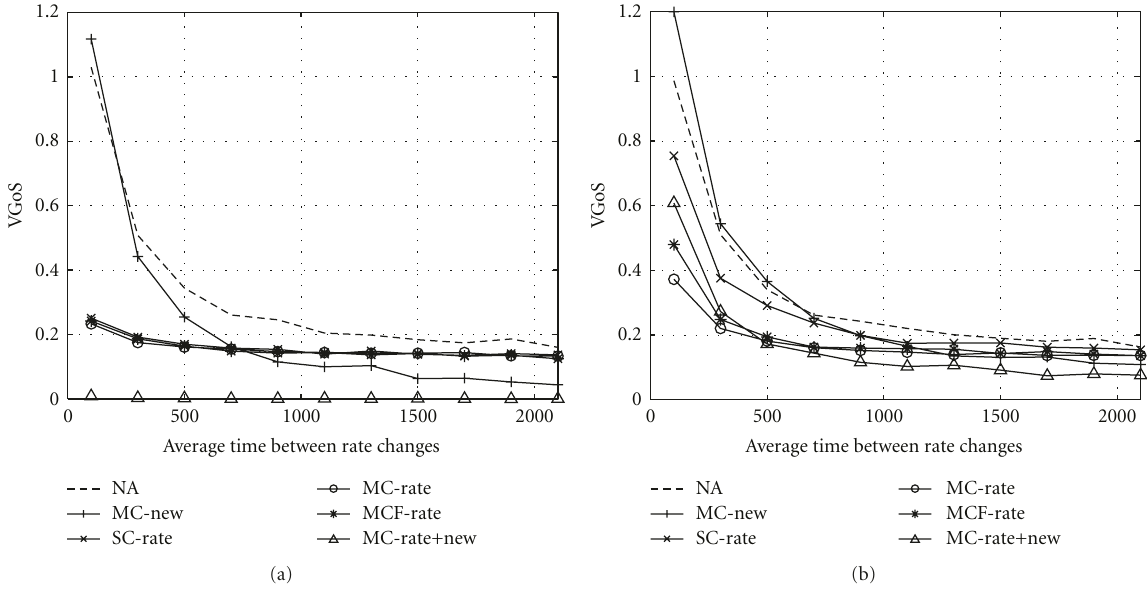
Figure 5: VGoS-factor versus frequency of rate changes at 5 erlangs with (a) 100% node participation, (b) 40% node